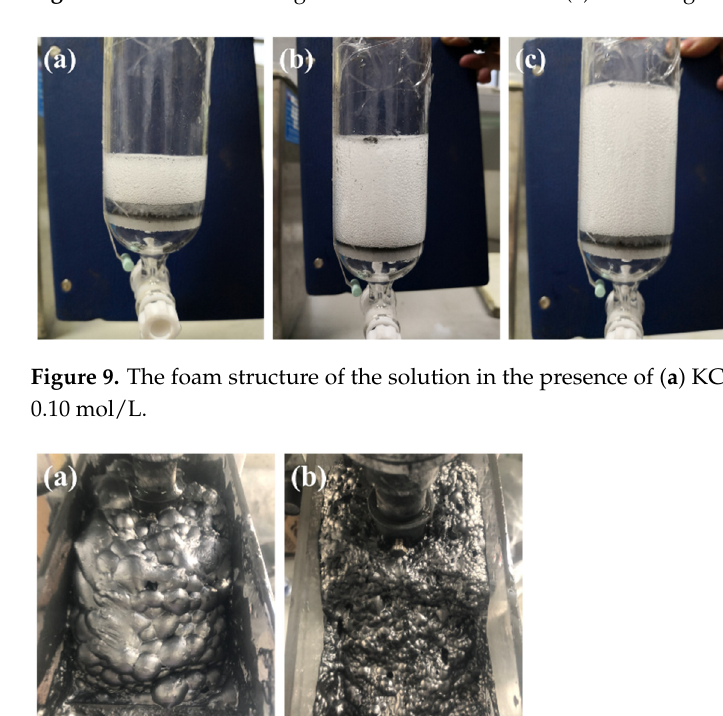
Figure 8. The effect of inorganic salt concentration on ( a ) foam height and ( b ) foam half-life.